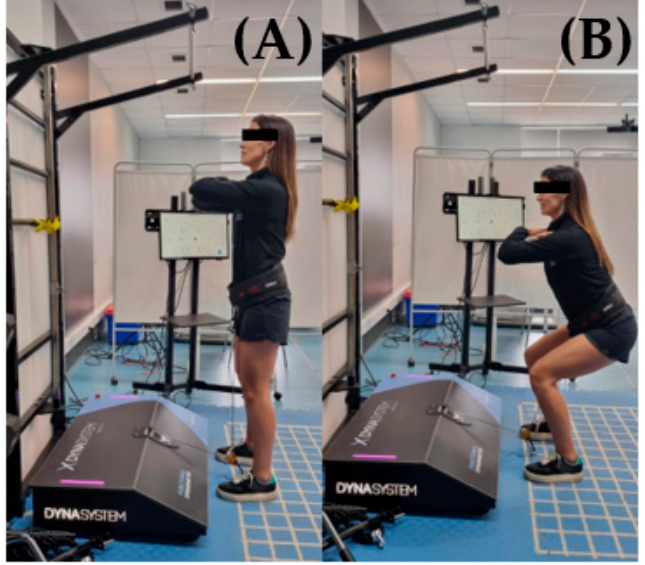
Figure 1. Half squat set-up. ( A ) Highest and ( B ) lowest